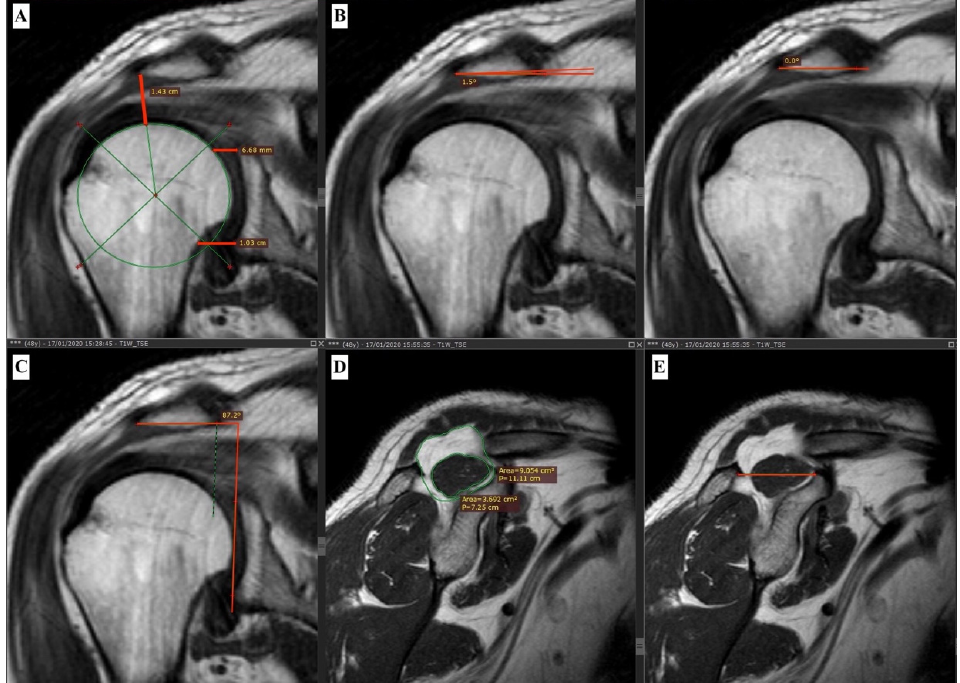
Figure 1. A 48-year-old man with clinical suspicion of rotator cuff injury. T1 weighted (T1W) images with turbo spin echo (TSE) technique were acquired in the oblique coronal and sagittal coronal planes. Measurements of the subacromial space, superior and inferior glenohumeral joint spaces ( A ), acromial angle with and without axial traction ( B ), gleno-acromial angle ( C ), Goutallier classification ( D ) and Warner classification ( E ).